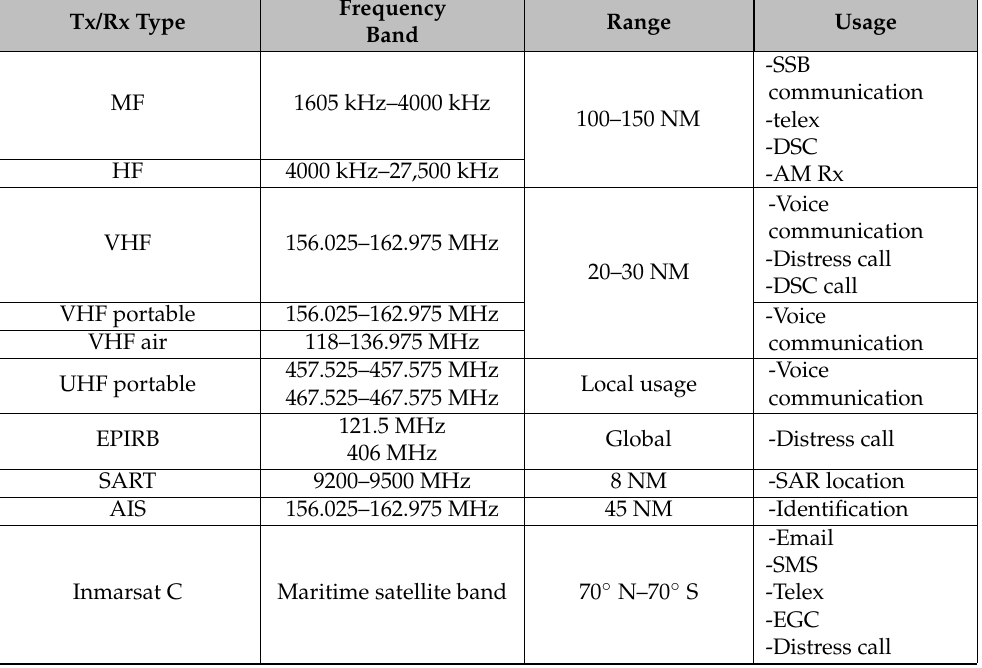
Table 2. Maritime communication devices and